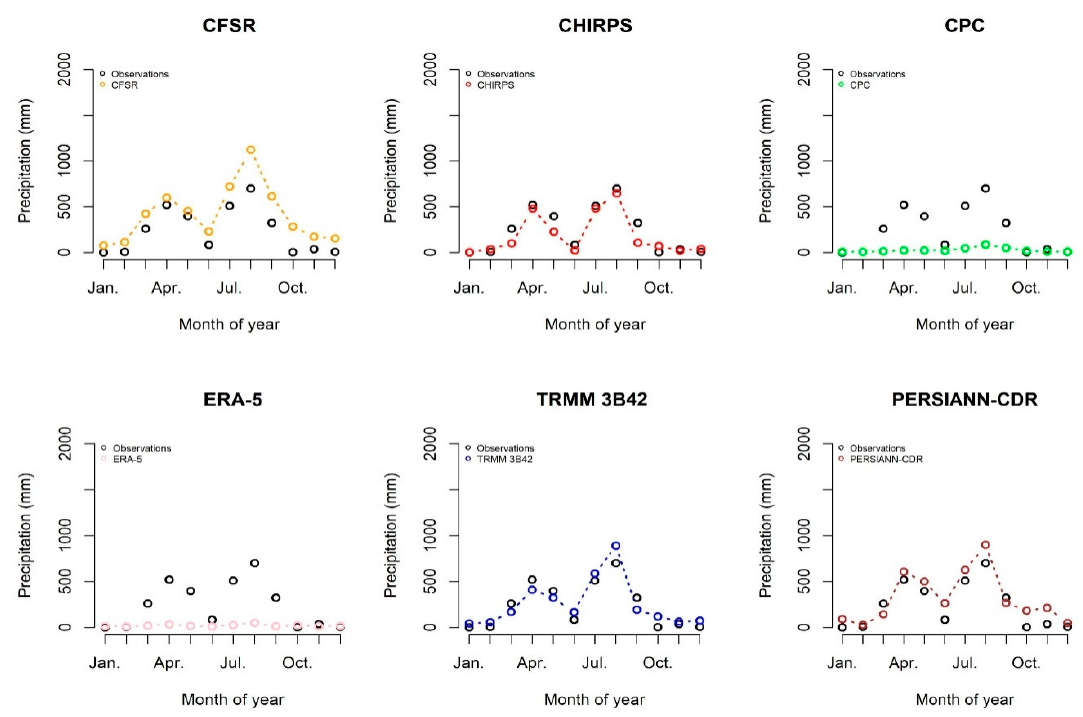
Figure 5. Monthly peak rainfall events captured by the gridded products and observations for the period 1998–2007.